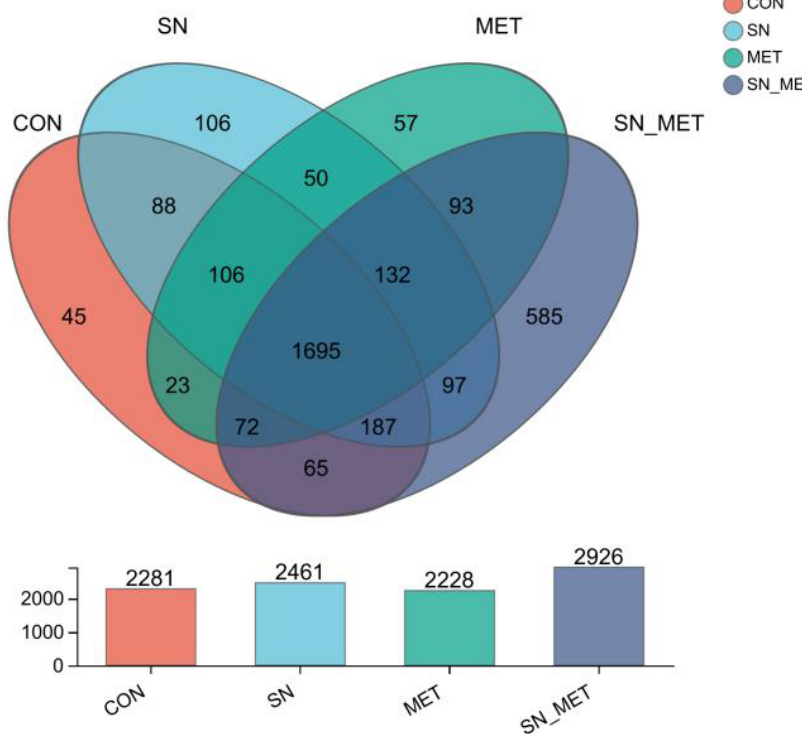
Figure 1. OTU distribution in the control (CON), 70 g/d sodium nitrate (SN), 15 g/d L-methionine (MET), and sodium nitrate group 70 g/d + L-methionine 15 g/d (SN+MET) groups.